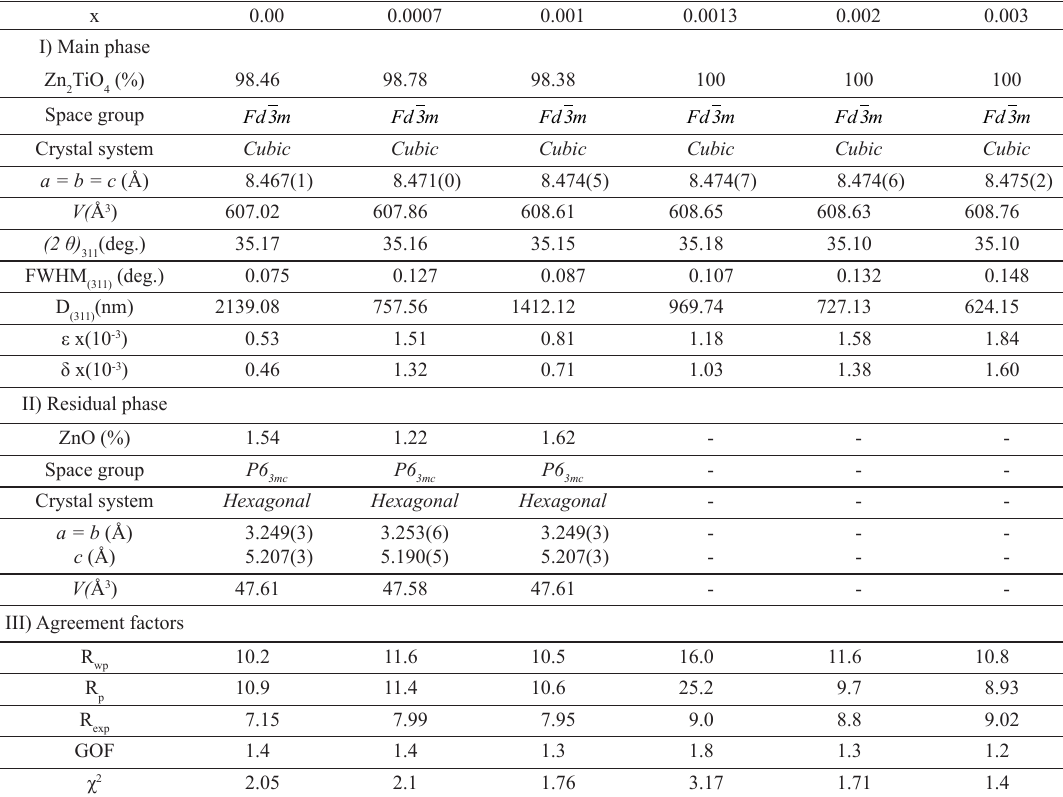
the measured data and the solid line represents the adjustment obtained from a pseudo-Voight function of Rietveld refinements. The first set of sticks (at the top) indicates the Bragg diffraction positions of Zn TiO and the second set of sticks (at the 2 4, bottom) is related to the Bragg diffraction positions of the ZnO phase. The bottom horizontal solid line is the difference between the measured diffraction and the calculated data obtained from Zn TiO PDF 860156 (ICSD 080851) 25 and 2 4 ZnO PDF 800075 (ICSD 067849) 26 . Results from X-ray data refinements are exhibited in Tables 1 and 2. The GOF-index (Goodness-of-Fit) indicates the discrepancy between the observed and expected values of X-ray diffraction data. The desired value of the GOF-index is 1.0 23 . The values for the Zn Ni TiO , where x =0.00, 2(1-x) 2x 4 0.0007, 0.001, 0.0013, 0.002 and 0.003, obtained from the Rietveld refinement indicate the correct identification of the sample phase(s) and of the crystallographic structure (space group). Table 1 shows that for the investigated Ni 2+ concentration interval, the space group, the cell parameter and the cell volume are not significantly affected when the Ni 2+ ion is introduced in the host. This fact can be explained by the low Ni 2+ concentration of the sample. The lattice parameters obtained from Rietveld refinements ( Table 1) indicate samples with a cubic (face-centered) space group. Due to the small difference between the values shown in Table 1 (< 0.3%), the cell volume of Zn TiO and Zn 2 4 Table 1. Structural properties and Rietveld refinement parameters for cubic Zn Ni TiO , where x =0.00, 0.0007, 0.001, 0.0013, 0.002, and 0.003. 2(1-x) 2x 4 x 0.00 I) Main phase Zn TiO (%) 2 4